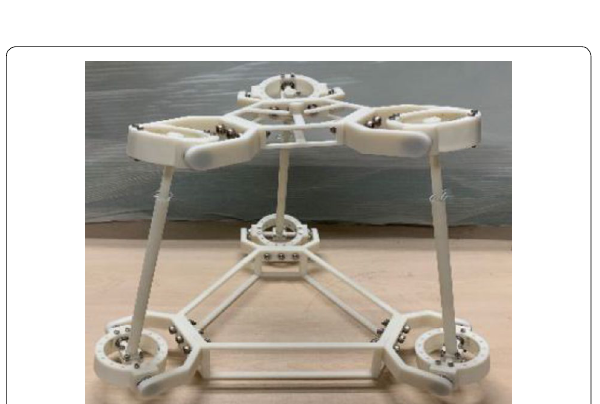
Figure 17. Physical prototype of 3(rA)P(rA)